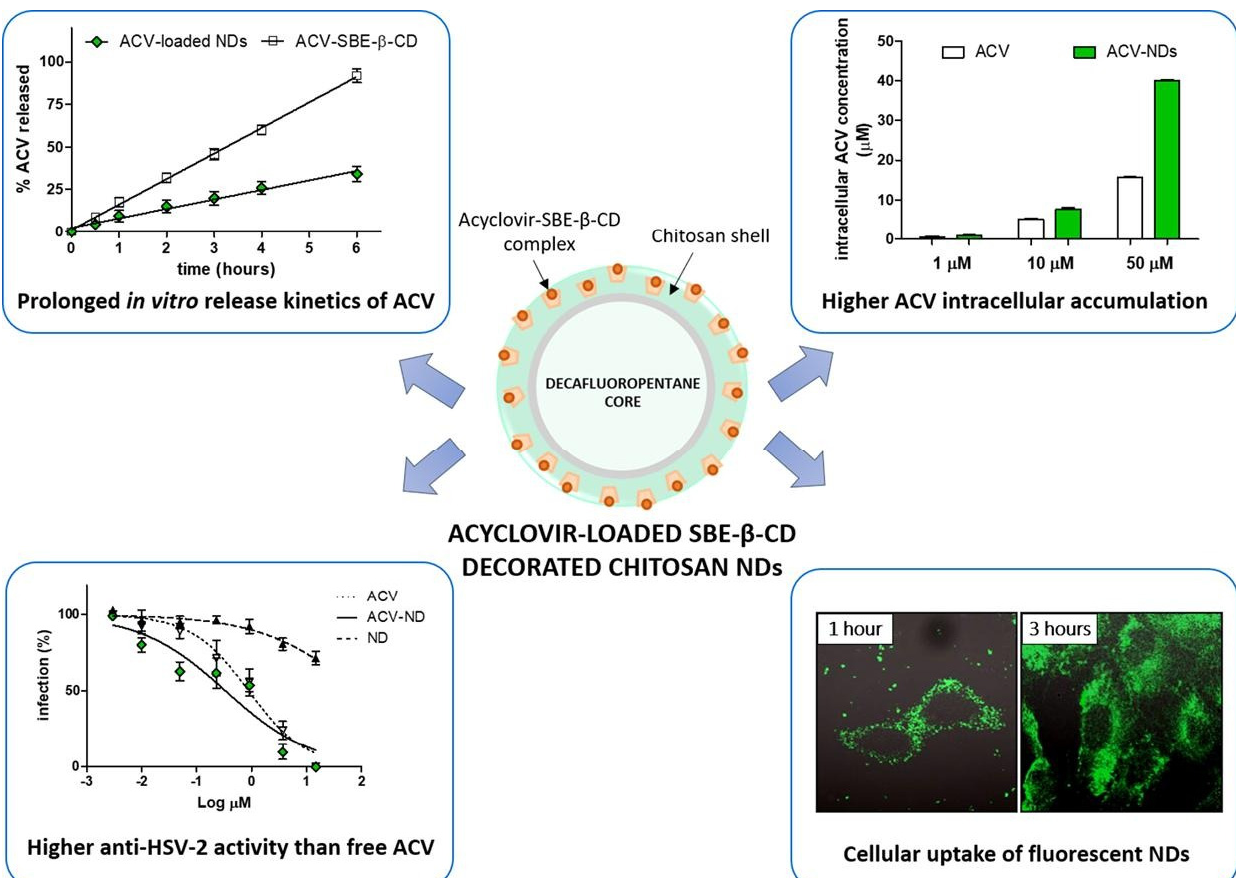
Figure 18. Properties of ACV-loaded SBE- β -CD (sulfobutyl ether- β -cyclodextrin)-decorated chitosan nanodroplets (NDs) [238]. Reproduced with permission from Elsevier (Copyright©2020).